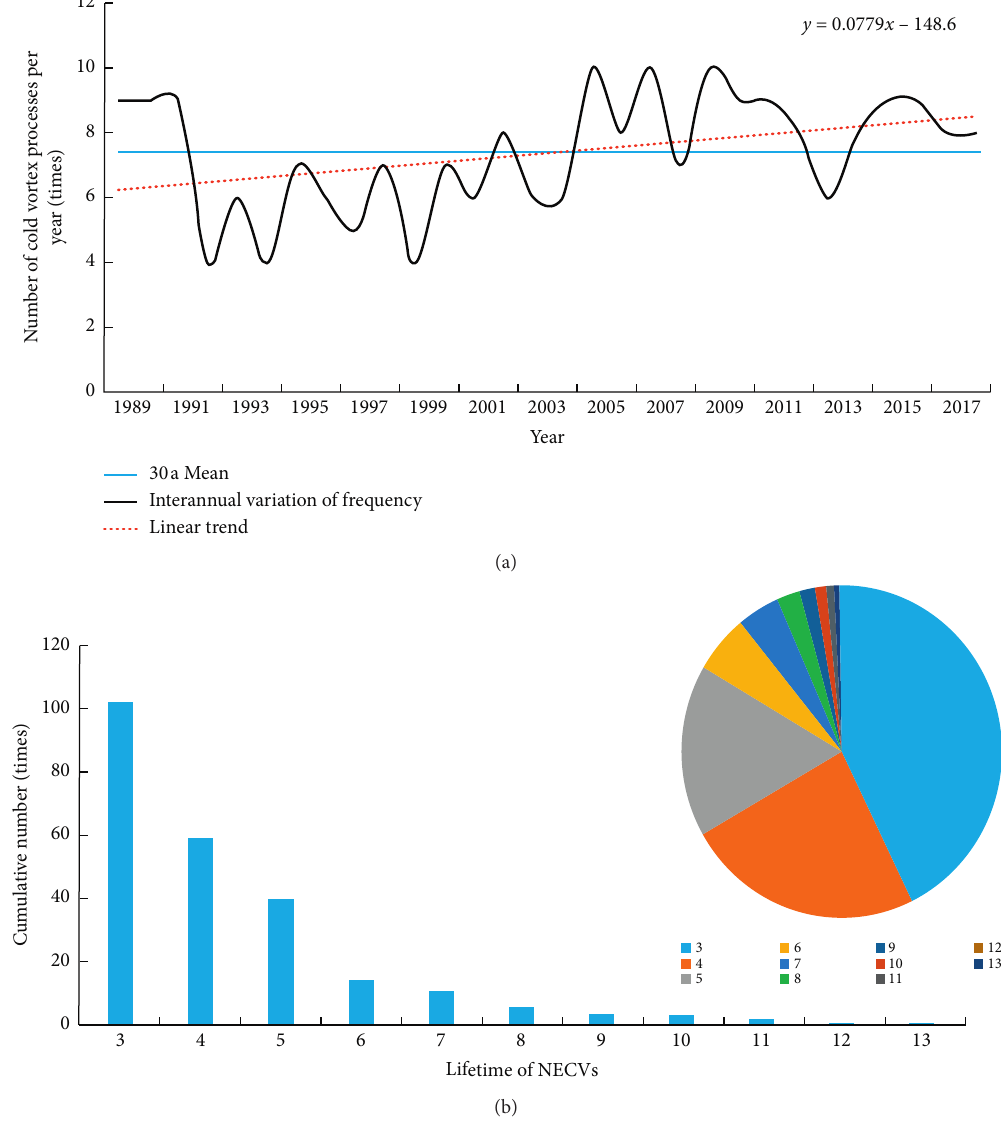
Figure 2: Interannual variation of NECV occurrence frequency (unit: times). (a) Interannual variations in the numbers of NECV occurrences and (b) the cumulative durations of NECVs per 30